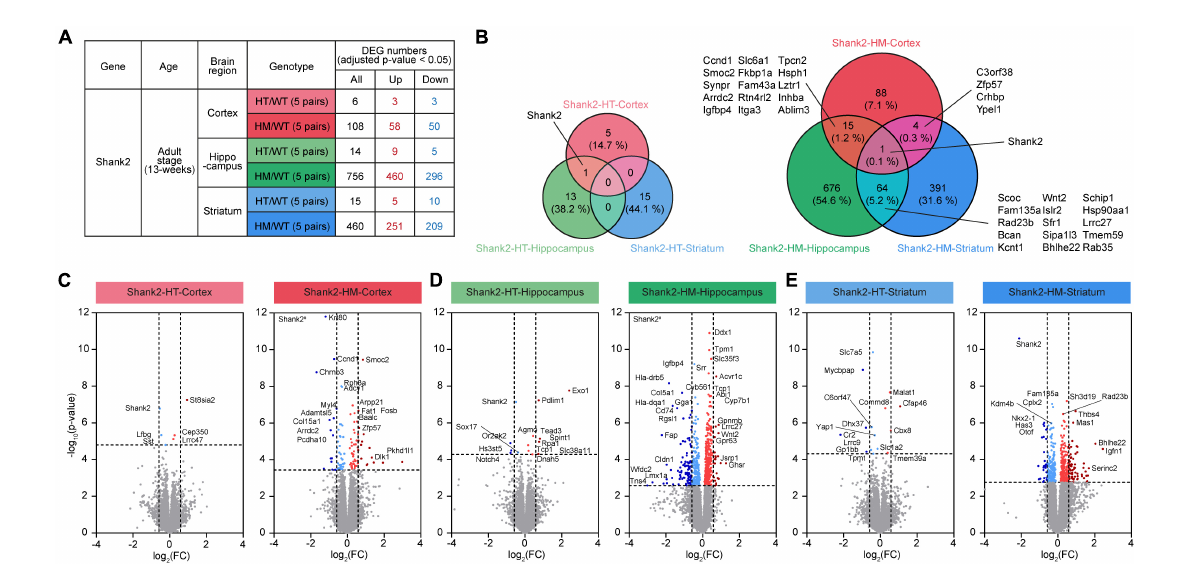
FIGURE1 Differentially expressed genes (DEGs) among Shank2-heterozygous (HT) and Shank2-homozygous (HM) transcripts in the cortex, hippocampus, and striatum. (A) Numbers of DEGs from cortical, hippocampal, and striatal regions in Shank2-HT and Shank2-HM mice relative to wild-type (WT) [13 weeks; male; n = 5 mice (WT), 5 (HT/heterozygote), and 5 (HM/homozygote)]. DEGs were defined as genes showing transcript changes above the cutoff (adjusted p -value < 0.05). (B) Venn diagrams showing the overlaps of DEGs between cortical, hippocampal, and striatal regions in Shank2-HT and Shank2-HM mice [13 weeks; male; n = 5 mice (WT), 5 (HT), and 5 (HM)]. (C–E) Volcano plot representations of DEGs from cortical, hippocampal, and striatal transcripts in Shank2-HT and Shank2-HM mice. The DEGs ( p -value < 0.05) were further color-coded to indicate those with strong fold changes ( > 1.5). Note that Shank2 was not indicated as a DEG in some volcano plots (HT-Striatum) because of the low adjusted p -values ( p = 0.2850), although their p -values were below 0.05 ( p = 0.0019). Shank2 # in HM-Cortex and HM-Hippocampus volcano plots indicate very small p -values [-log 10 (adjusted p -value) = 26 and 28 for HM-Cortex and HM-Hippocampus,